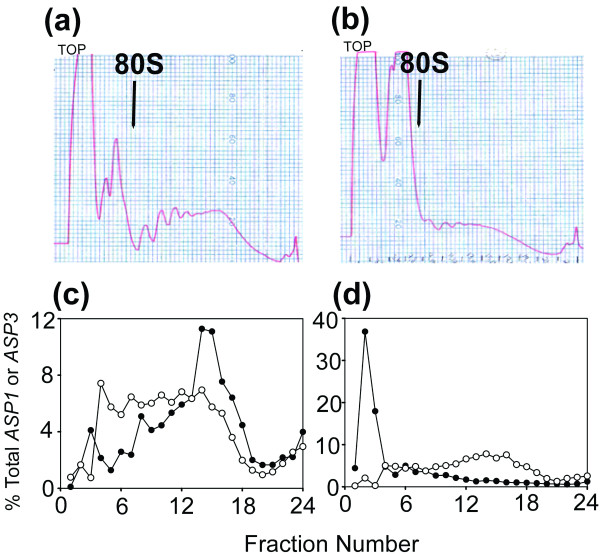
Translational responses to nitrogen starvation. Sucrose gradient centrifugation was performed and analyzed as described in Figure 2. The A254 profiles are shown of sucrose gradients with extracts from either (a) growing cells or (b) starved cells loaded onto gradients. The tops of the gradients and location of the 80S ribosome peak in panel a are indicated. (c) ASP1 mRNA levels across sucrose gradients from growing cells (filled circles) or cells nitrogen starved for 30 minutes (open squares). RNA was prepared and analyzed as described in Figure 2. The top of the gradient is to the left and the position of the 80S monosome is marked with the arrow. (d) ASP3 mRNA levels; cell extracts and symbols are as in (c).